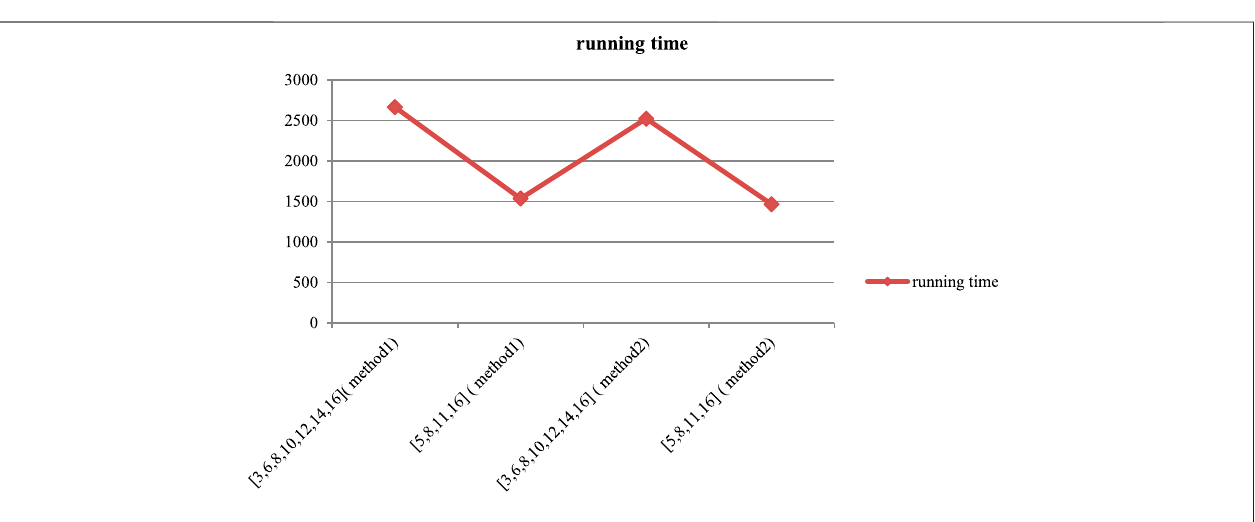
FIGURE 2 | Comparison of running time of two optimization algorithms for factoring integer 376289.